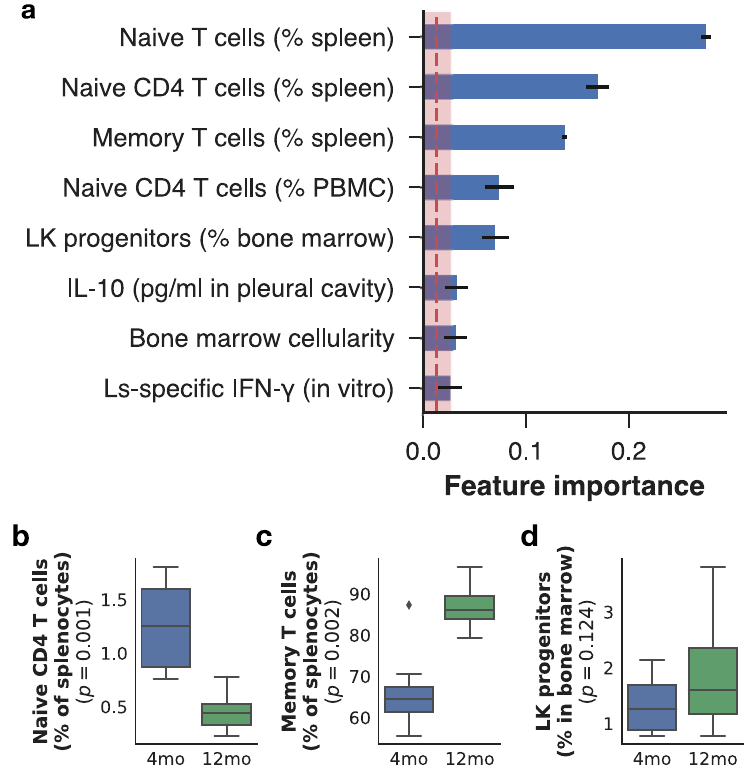
Figure 2. Naive and memory T cell proportions were the main differentiator between 4mo and 12mo mice. The importance of each immune factor in predicting host age was estimated by measuring the average gain in the purity of daughter nodes when decision tree splits used that feature for classifying all 32 mice mice as young or old irrespective of their infection status. Thus, the greater the importance of an immune feature, the more useful it is in classifying a mouse as 4mo or 12mo. We used a cut-off of 3 standard errors (red-shaded zone) above the mean (red dotted line) of all importances below which features were not considered robust enough for further inference. ( a ) Top predictors of age in mice, whether infected or not, achieved 97% accuracy on average over 10 repeated random training sets in correctly clarifying mice as 4mo or 12mo. Horizontal bars represent means and associated errors of the feature importances generated from 10 models trained on different nested random 75%/25% train/test repeats. Top predictors included the proportions of naive and memory T cells in the spleen as expected under thymic involution (see Supplementary Fig. S3): in the spleen, ( b ) the proportion of naive T helper cells (CD3 + CD4 + ) had decreased, whereas ( c ) the proportions of memory T cells exceeded 80% of all splenic T cells in 12mo mice while ranging between 55% and 72% in 4mo mice. ( d ) Among HSPC within the bone marrow, Lin − c-Kit + Sca-1 − (LK) cells were found in greater proportions in 12mo than in 4mo mice. See methods section for details on feature importance calculations. Horizontal bars represent means and associated errors of the feature importances generated from models trained on and testing against 10 repeated 75%/25% random splits of the full dataset. In boxplots, horizontal lines represent the group median, boxes the interquartile range, whiskers the overall range, and points represent outliers ( <± 1.5 × the interquartile range, n = 16 per mice